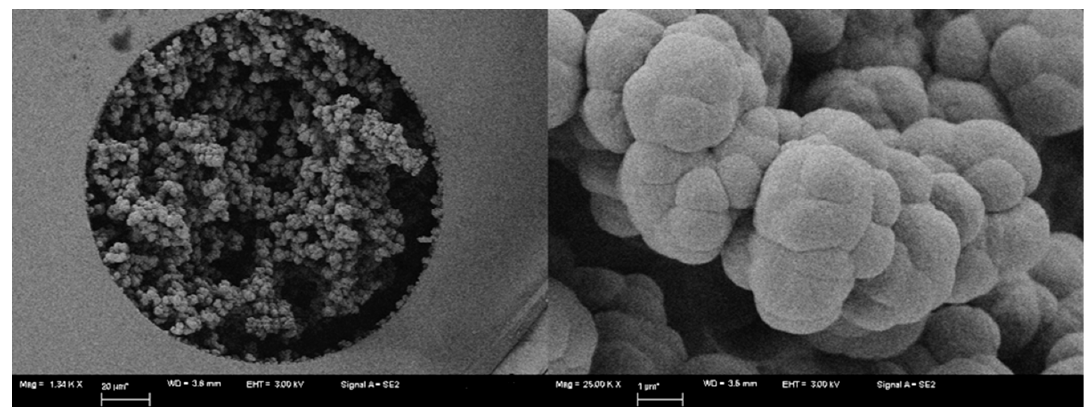
Figure 2. SEM of column C1 at 1200× and 25,000× (left and right, respectively) shows small micro-globules with rough surface.